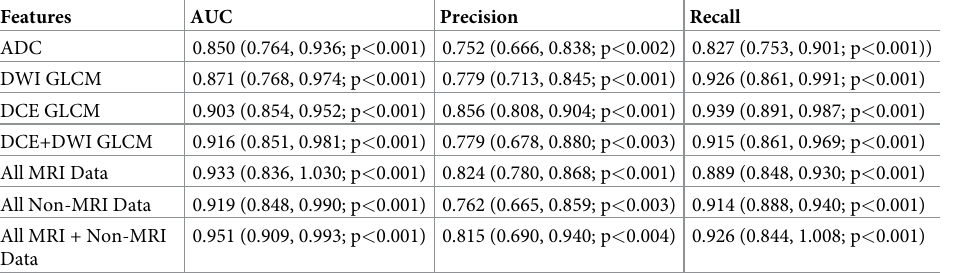
Table 3. Model performances for models trained on ADC, DCE(GLCM), DWI(GLCM), their combinations, all non-imaging data, and the combination of all MRI and all non-MRI data with 5-fold cross-validation. Features